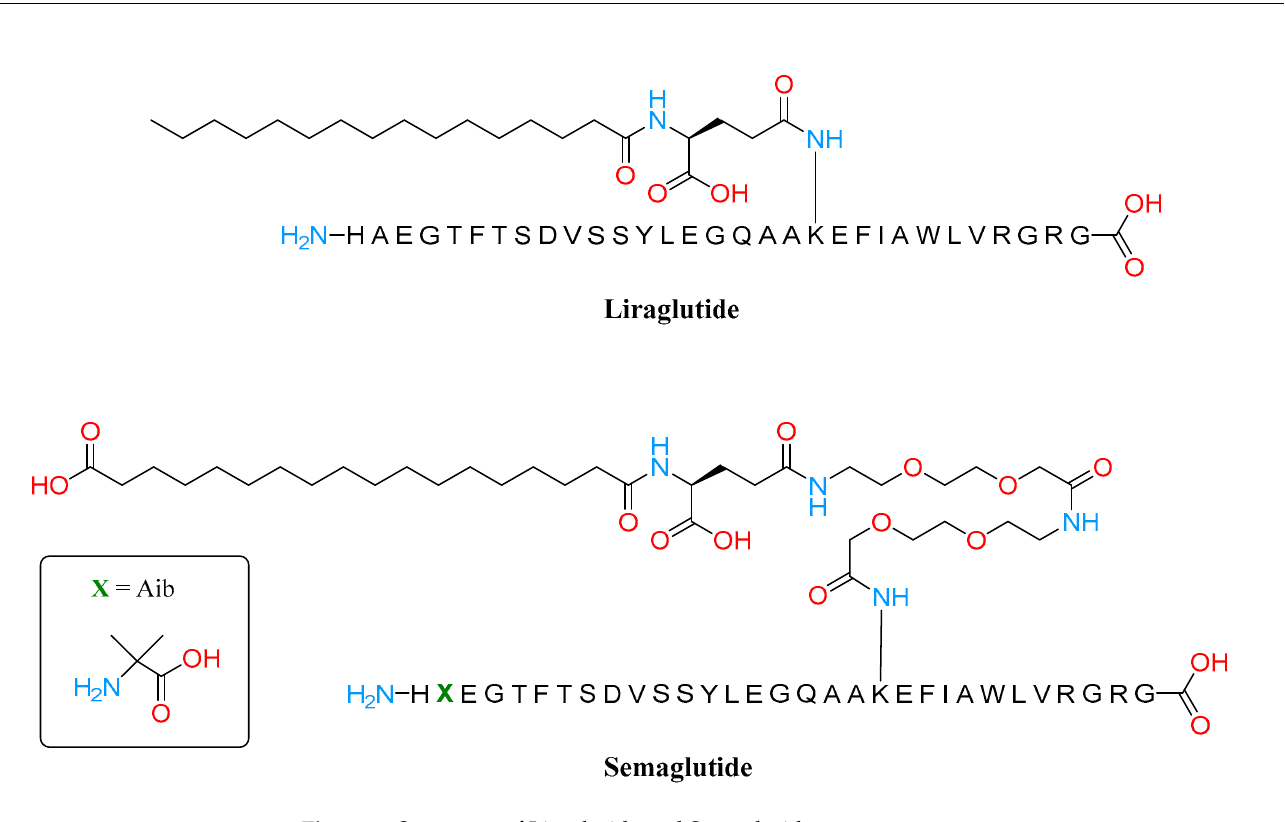
Figure 4. Structures of Liraglutide and Semaglutide. Liraglutide and semaglutide are both long-acting GLP1RAs that exhibit pharmacodynamic e ff ects for 24 h per day despite di ff erent dosing intervals and dosages.